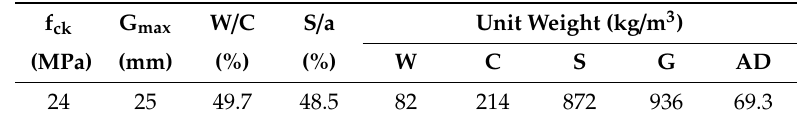
Table 1. Concrete mix